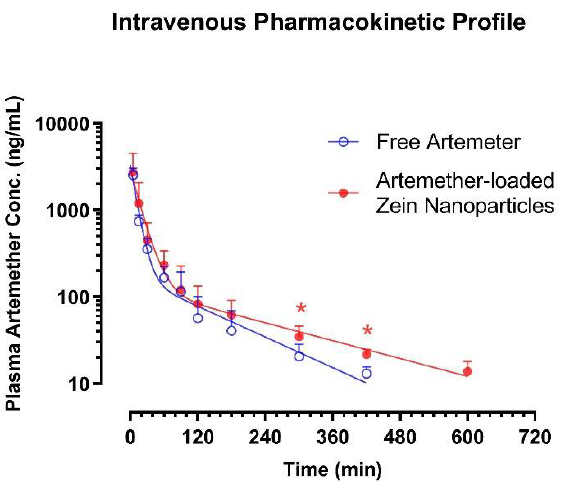
Figure 11. Intravenous pharmacokinetic profiles of artemether. The male Sprague–Dawley rats received respective intravenous administration of artemether in nanoparticles or cosolvent formulation at 5 mg/kg. Data are presented as mean ± SD; n = 5 except n = 3 at 420 min for rats that received artemether in cosolvent. * p < 0.05 between nanoparticle group and cosolvent group, two-tailed unpaired t -test. Table 2. Intravenous pharmacokinetic parameters of artemether a .